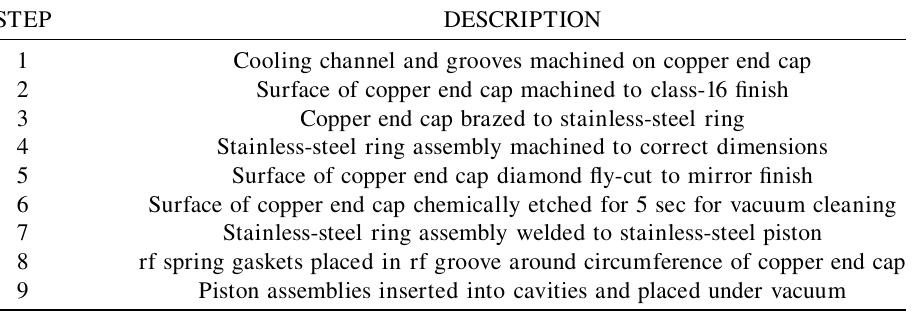
TABLE IV. Piston assembly and copper end cap surface